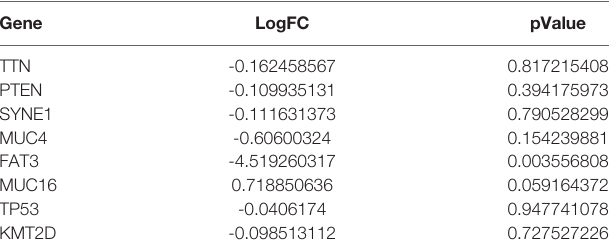
TABLE 1 | Analysis of differential expression of 8 genes between high and low TMB groups. Gene LogFC pValue